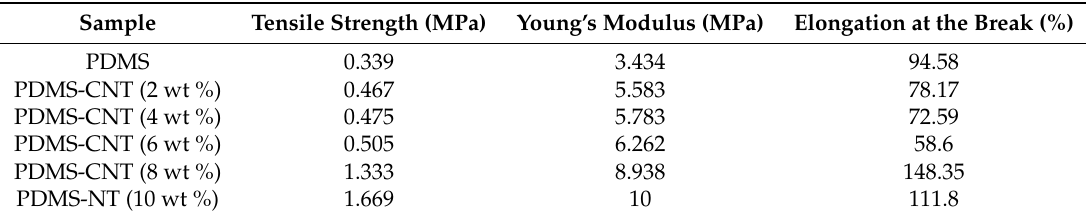
Table 1. Mechanical properties of composites.